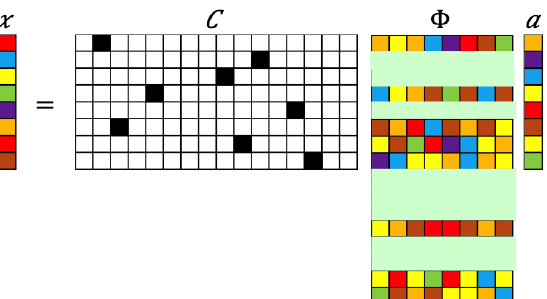
Figure 2. Schematic illustration of sparse sensor placement. The pastel-colored rectangles represent rows activated by the sensors denoted in the measurement matrix through dark